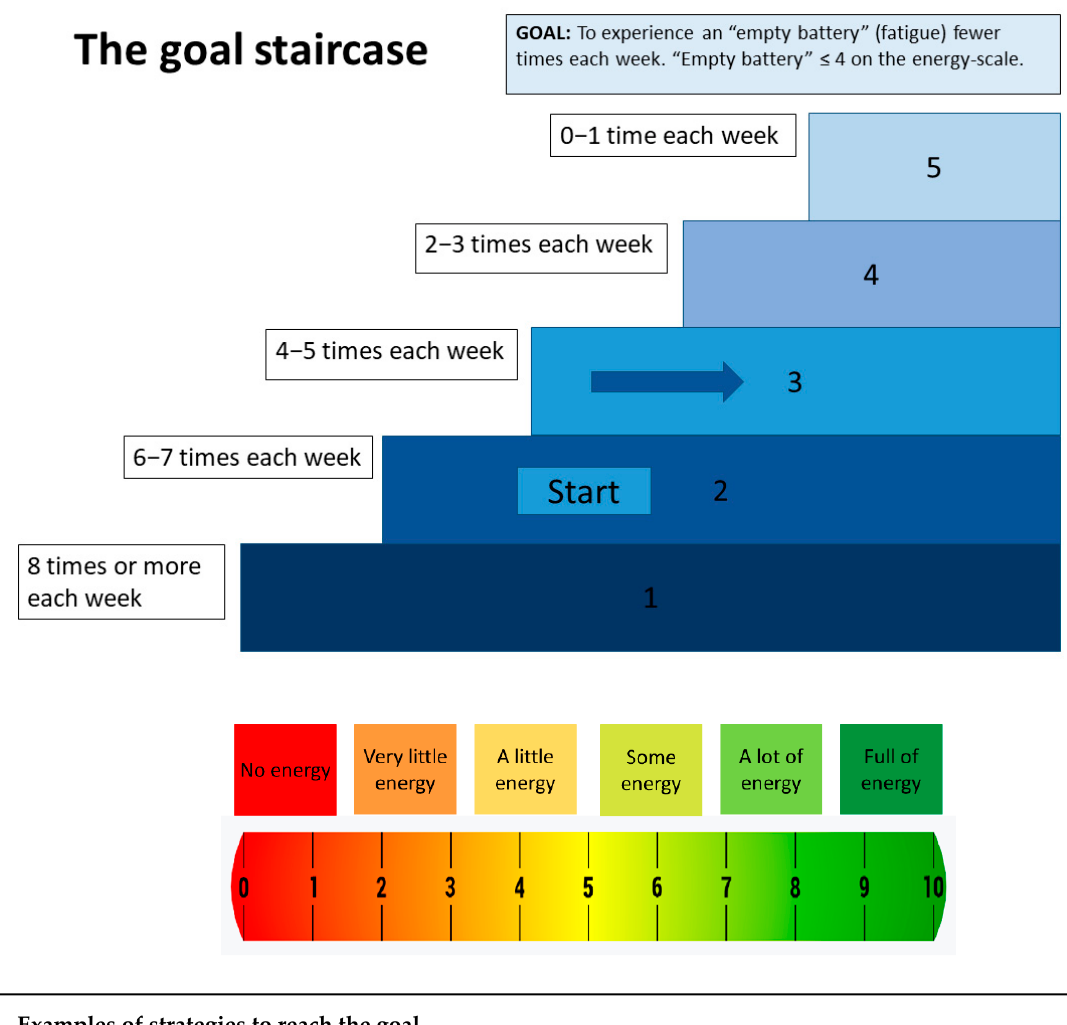
Examples of strategies to reach the goal